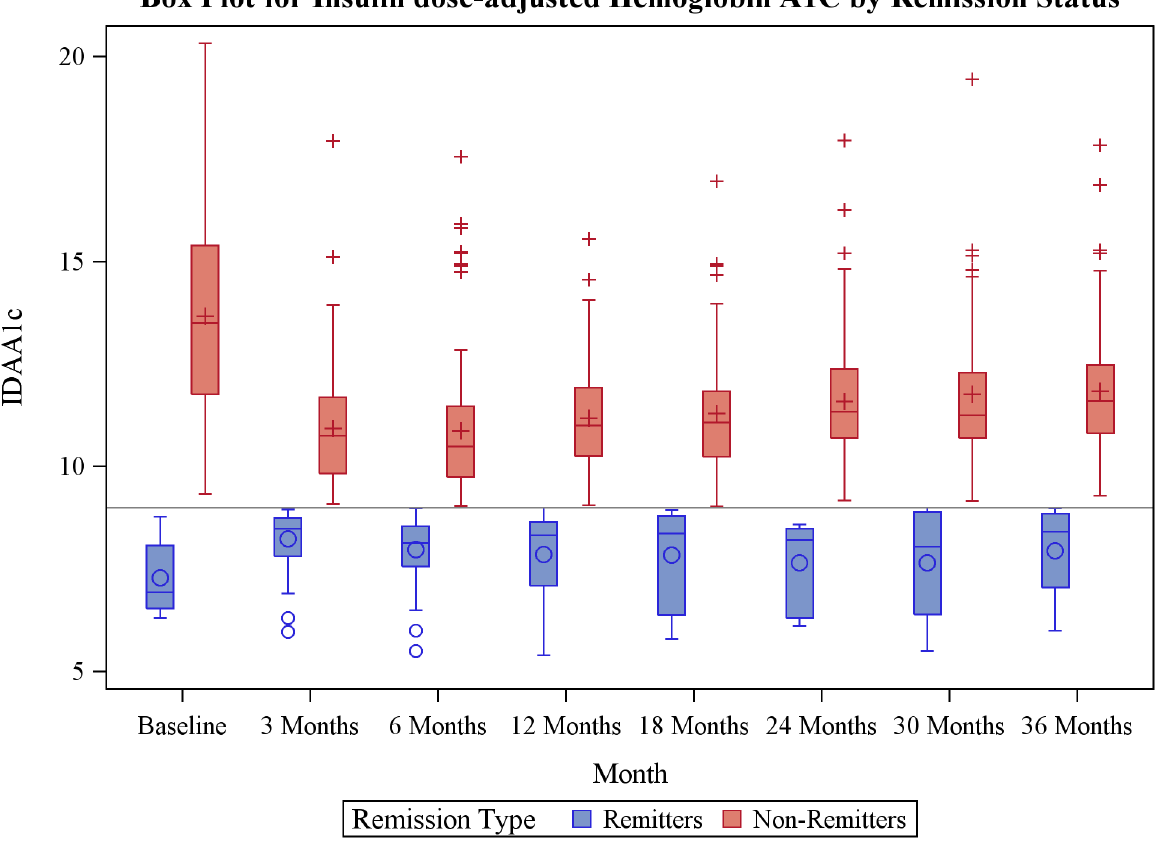
Fig 4. Box plot for the change in insulin dose adjusted hemoglobin A1c level over time by remission status.